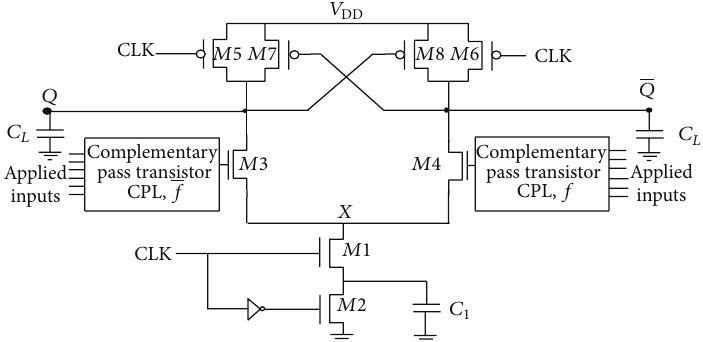
Figure 3: Basic architecture of H-DyCML